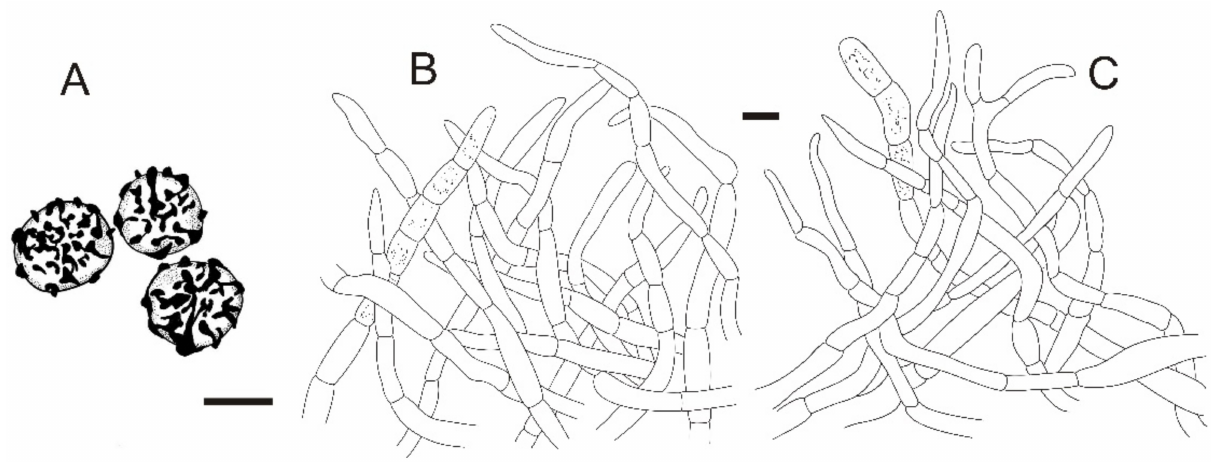
Figure 14. Microscopic features of Russula sinoparva (BJTC ZH441). ( A ) Basidiospores. ( B ) Hyphal terminations near the pileus margin. ( C ) Hyphal terminations near the pileus center. Scale bar: ( A ) = 5 µ m; ( B , C ) = 10 µ